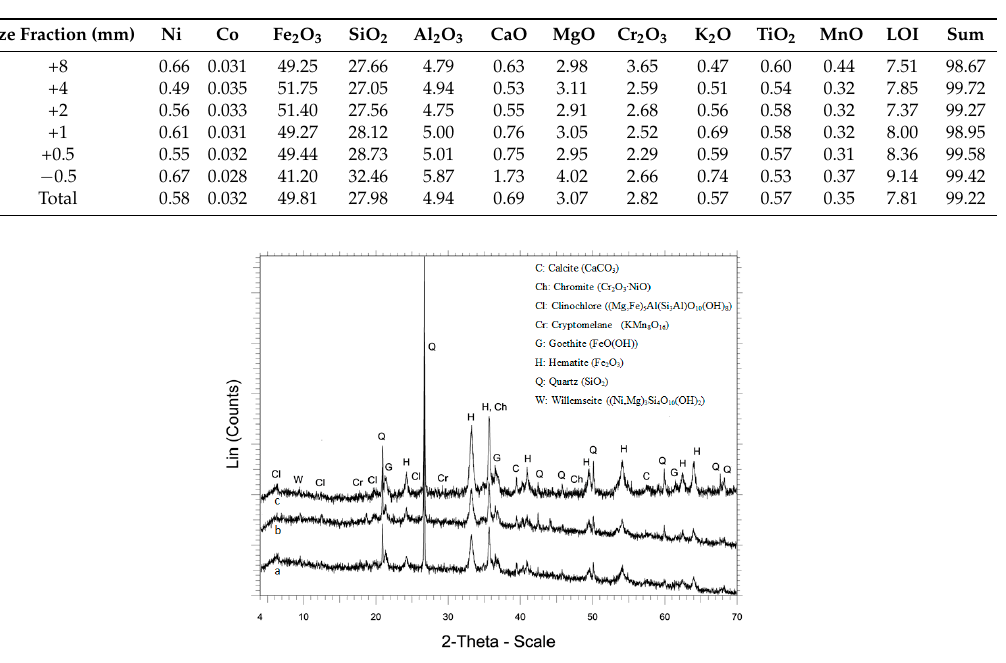
Figure 1. Particle size distribution of laterite from Agios Ioannis (LAI) used in column leaching tests. Table 2. Chemical composition (% w/w) of LAI size fractions.